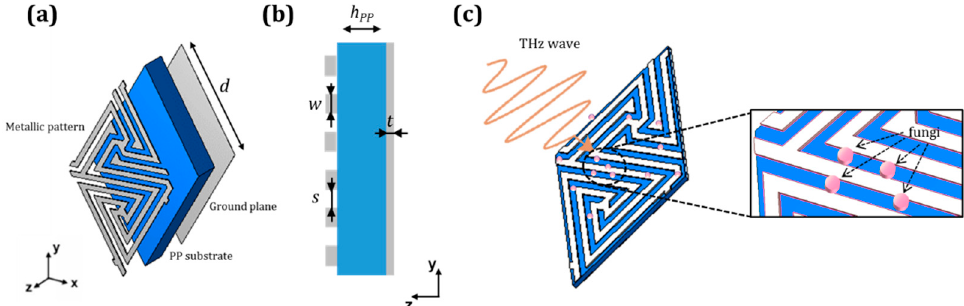
Figure 1. Front ( a ) and cross-sectional ( b ) views of the designed labyrinth metasurface unit cell. Metallization is shown in gray and polypropylene (PP) substrate in blue. Relevant dimensions: h PP = 29 µ m, d = 36.4 µ m, t = 0.4 µ m, s = 1.5 µ m; w = 1.5 µ m. ( c ) Schematic of the labyrinth metasurface working as a fungi metasensor. Fungi are modeled as cylinders of radius r f = 2 µ m, height h f = 1 µ m, and dielectric permittivity ε f = 8 and are randomly distributed on the unit cell surface.